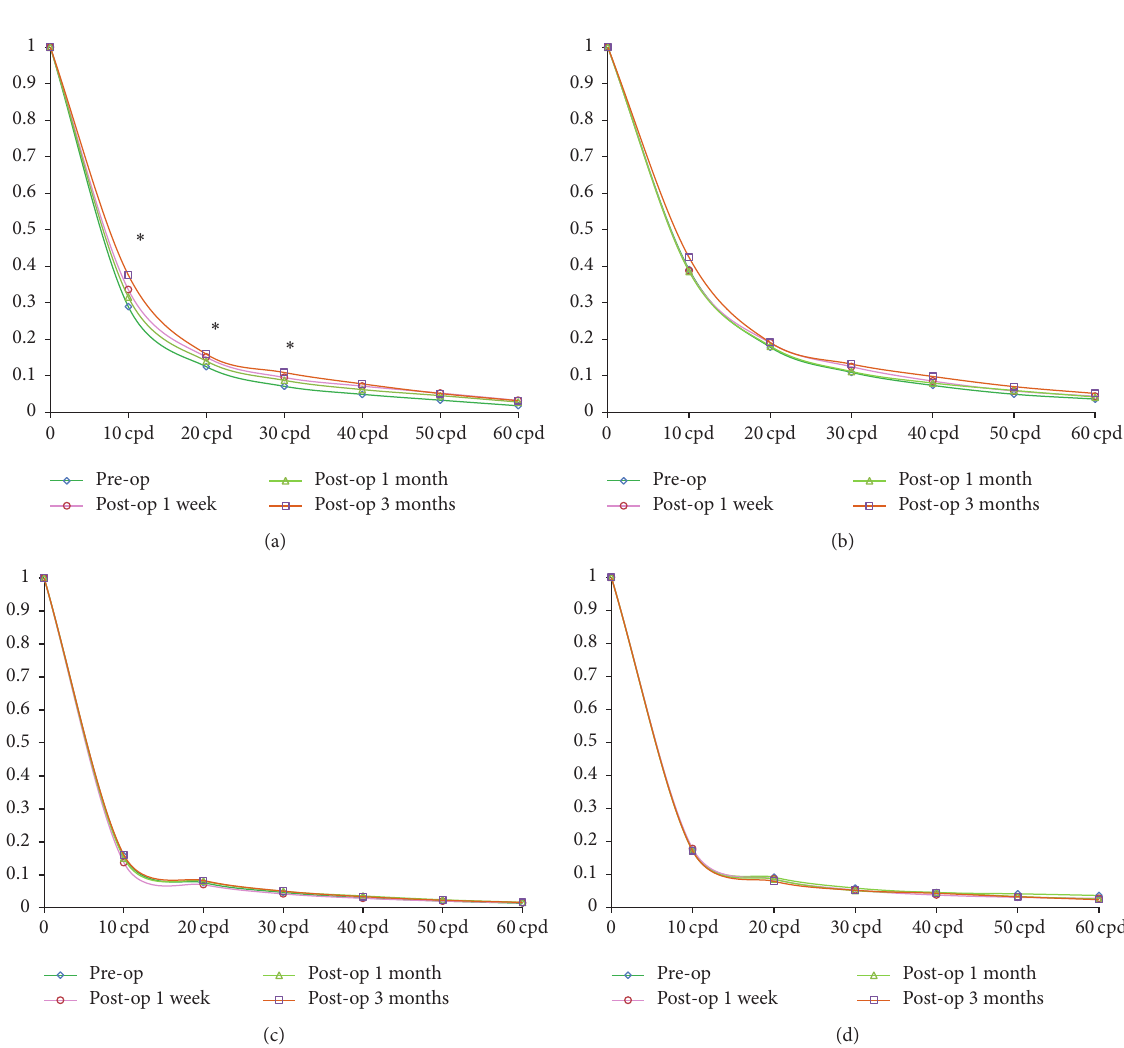
Figure 2: The changes of MTF values before and 1 week, 1 month, and 3 months after Femto-LASIK procedure. (a) The change of MTF curve at vertical meridian at 3 mm pupil diameters; (b) the change of MTF curve at horizontal meridian at 3 mm pupil diameters; (c) the change of MTF curve at vertical meridian at 6 mm pupil diameters; (d) the change of MTF curve at horizontal meridian at 6 mm pupil diameters. ∗ Significant difference among different follow-up